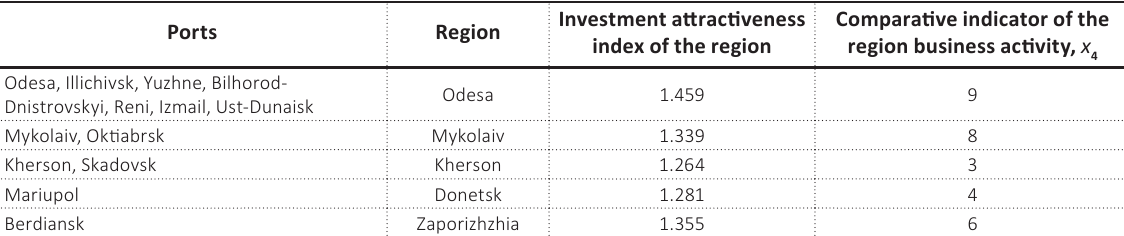
Table 7. Determining the comparative indicator of business activity in the region Source: Developed by the authors. Ports Region Investment attractiveness index of the